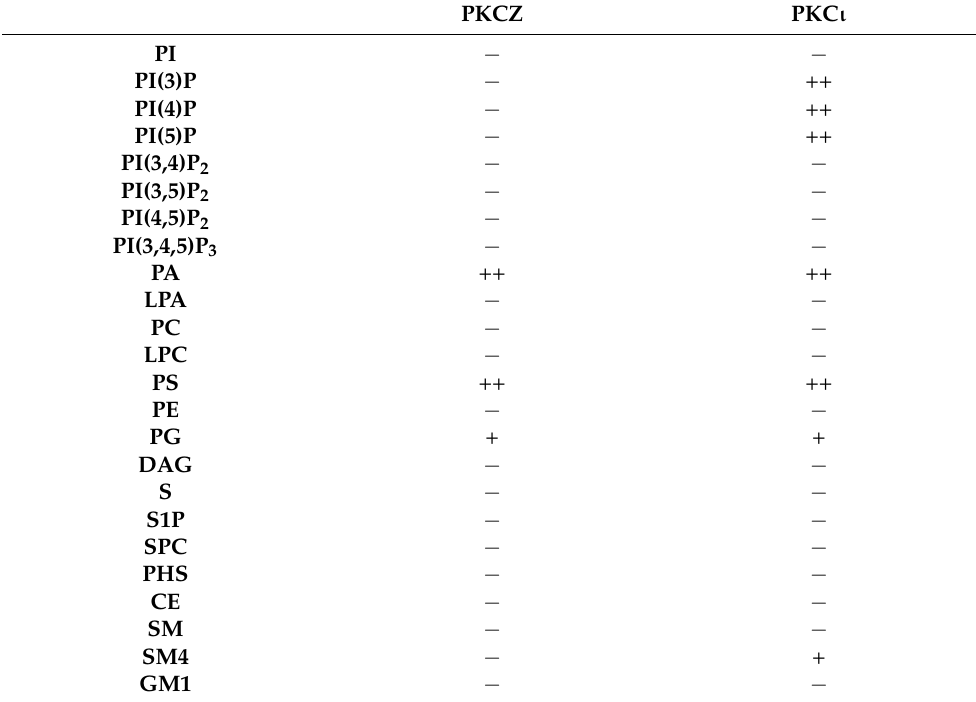
Table 1. Protein/lipid interactions detected by the lipid overlay